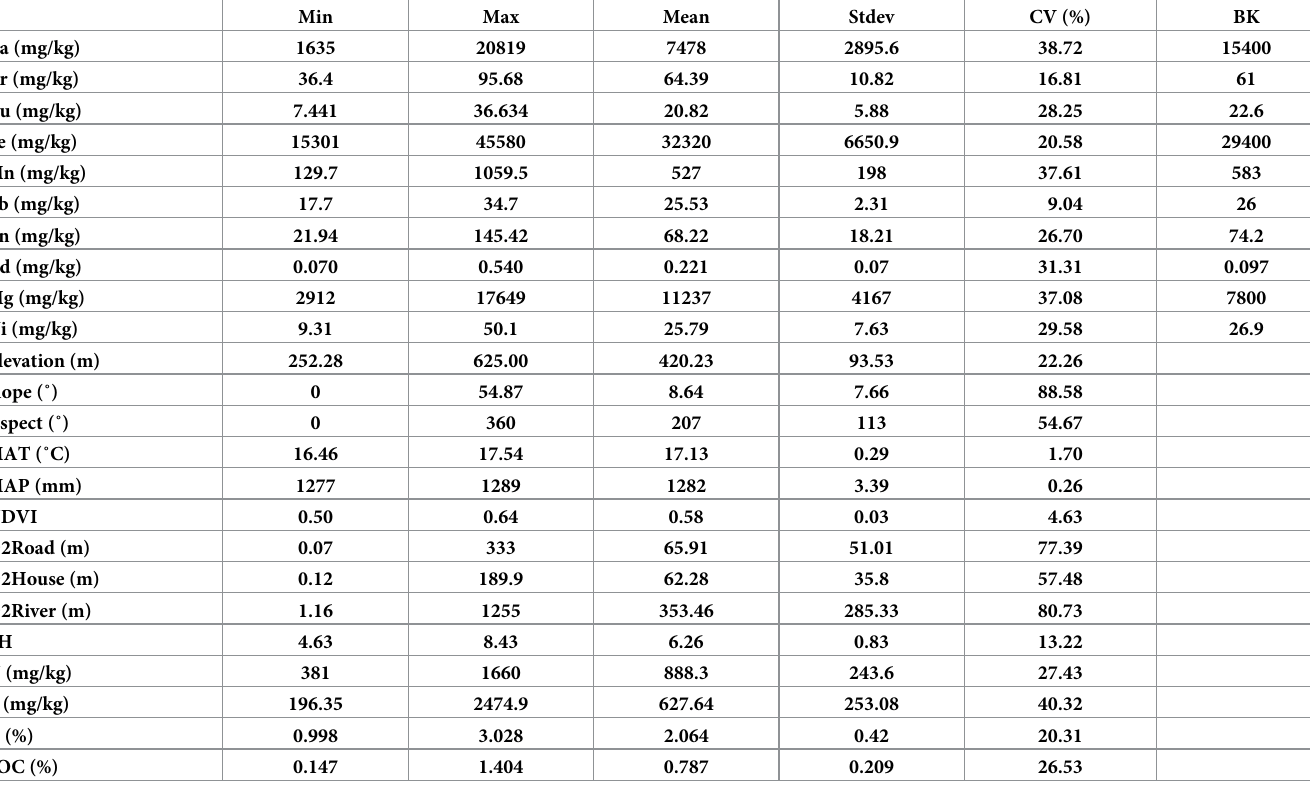
Table 2. Summary statistics of concentrations of metal elements and explanatory parameters (sample number = 300). Min Max Mean